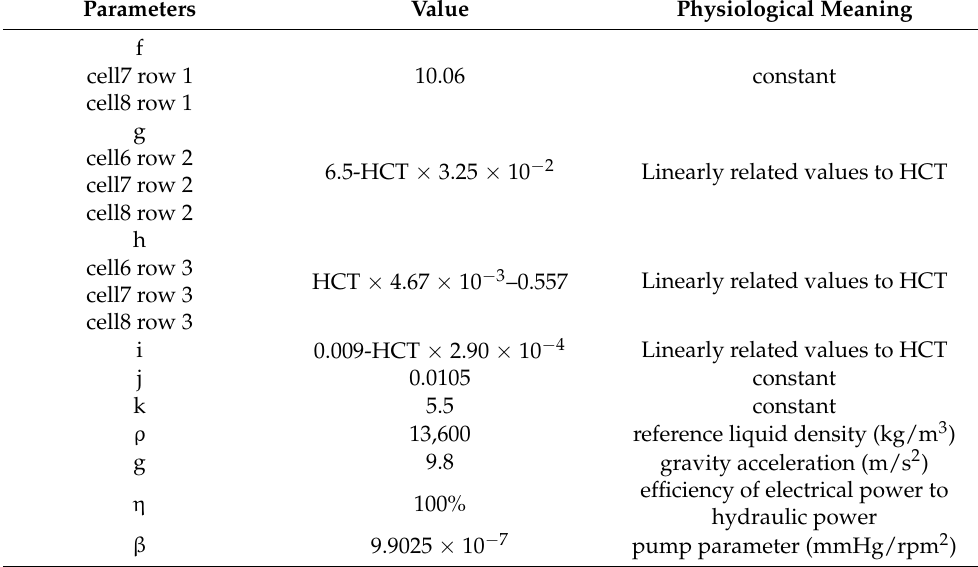
Table 1. Setting of model